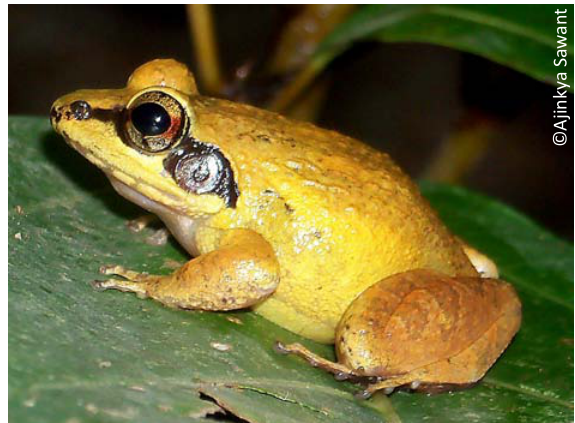
Image 9. Indirana beddomii